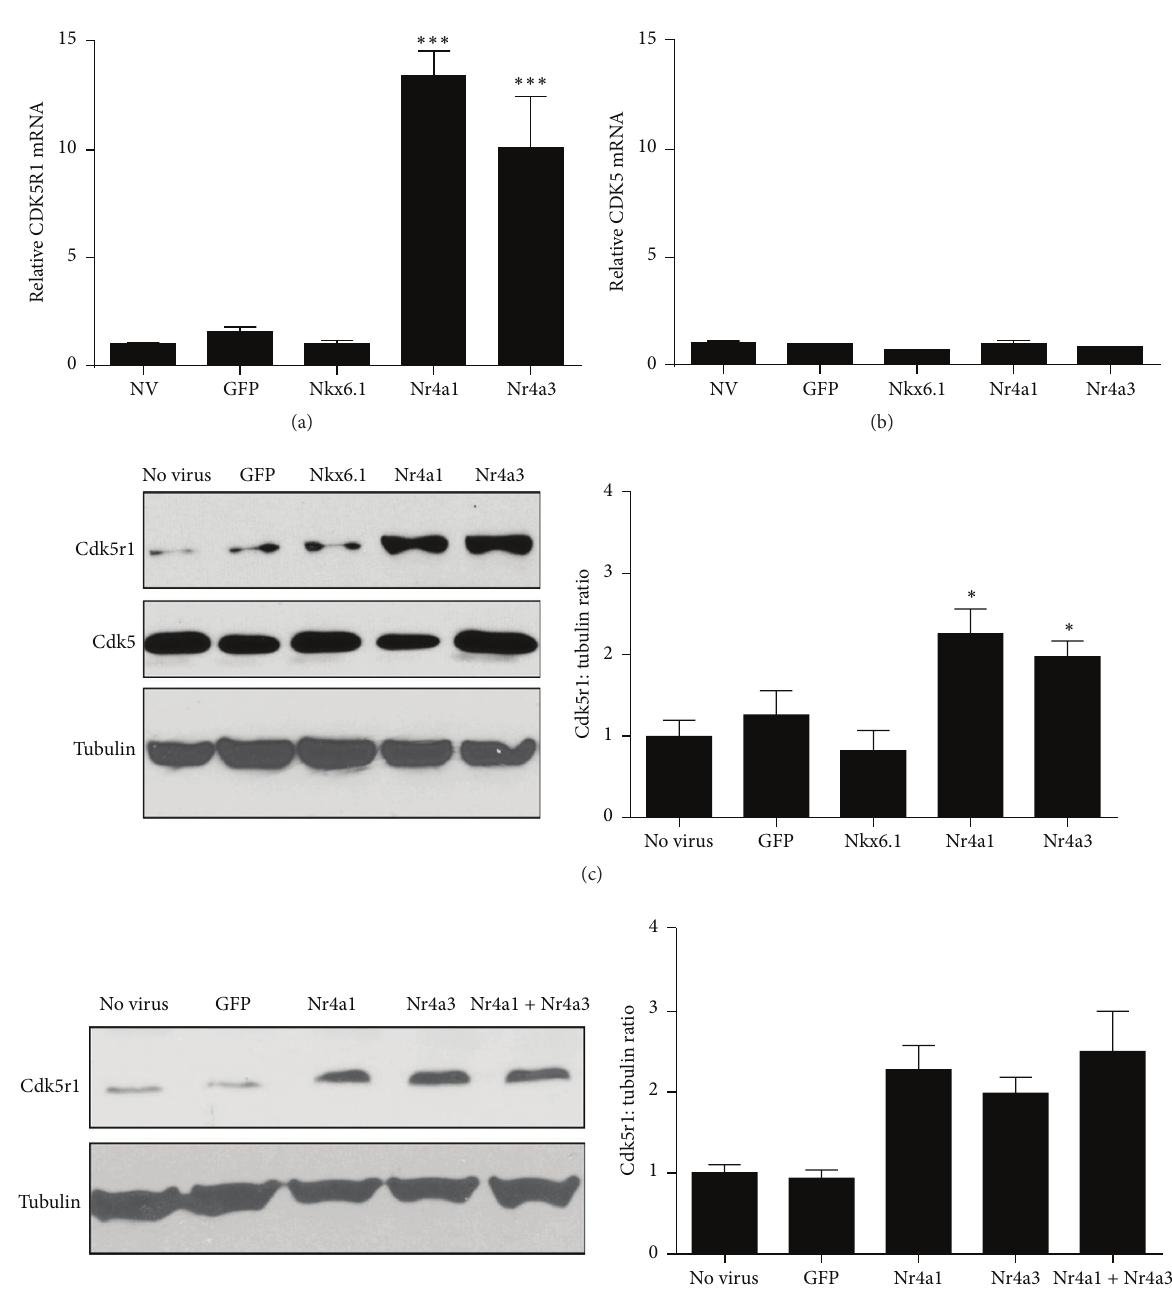
Figure 2: Overexpression of Nr4a1 and Nr4a3 induces Cdk5r1 expression in primary rat islets. Rat islets were treated with AdCMV-GFP, AdCMV-Nkx6.1, AdCMV-Nr4a1, or AdCMV-Nr4a3. (a) Cdk5r1 mRNA levels increase is induced by Nr4a1 and Nr4a3 but not by Nkx6.1, while (b) Cdk5 mRNA levels are unchanged by overexpression of Nkx6.1, Nr4a1, or Nr4a3. Data represent the mean ± SEM of six independent experiments. (c) Representative western blot and quantitation demonstrate that islets transduced with AdCMV-Nr4a1 or AdCMV-Nr4a3 induce upregulation of Cdk5r1 protein levels. Data represent the mean ± SEM of six independent experiments. (d) Representative western blotandquantitationdemonstratethatisletstransducedwithAdCMV-Nr4a1andAdCMV-Nr4a3havenoadditiveincreaseonCdk5r1protein levels. Data represent the mean ± SEM of three experiments for western blots. ∗ 𝑝 ≤ 0.05 ; ∗∗∗ 𝑝 ≤ 0.001 . p value represents the comparison between Nr4a1- or Nr4a3-treated and GFP-treated